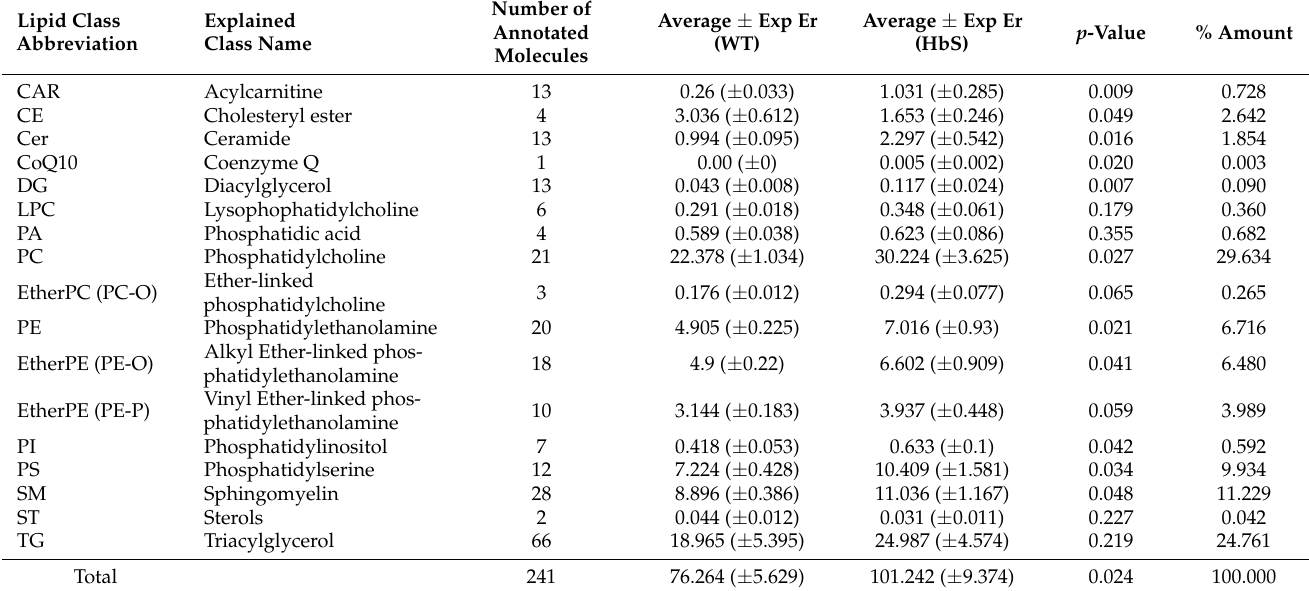
Table 1. Comparison of the concentration of lipid class of human erythrocytes cells in the two experimental groups HbS (n = 4) and WT (n = 5). The average concentrations are reported in nmol/50 million of RBC. The number of annotated molecules is the number of single molecular species